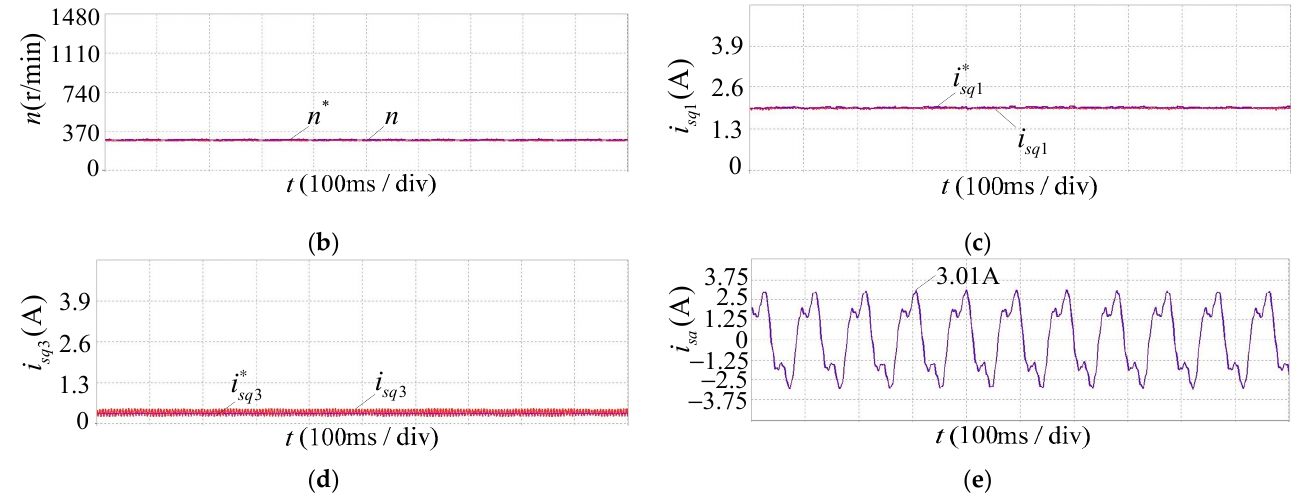
Figure 5. Experimental waveform of model predictive control and field-oriented control (MPC+FOC) system at 300 r/min, showing ( a ) the whole process; ( b ) the speed n ; ( c ) the current i sq 1 ; ( d ) the current i sq 3 ; and ( e ) the phase current i sa .